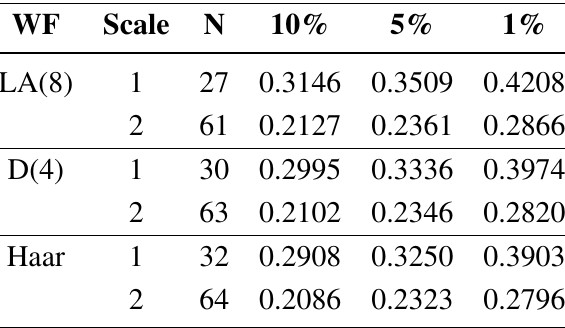
Table 2. Monte Carlo simulation critical